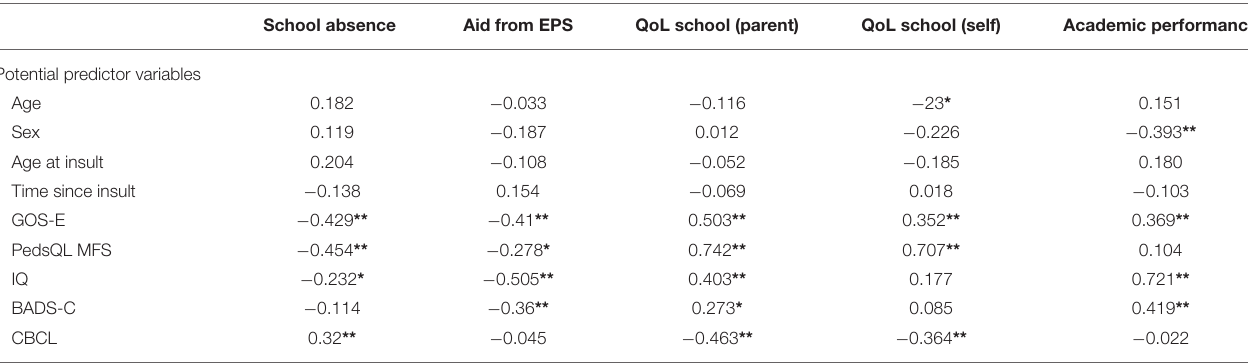
TABLE 3 | Correlations between functional school outcome variables and potential predictor